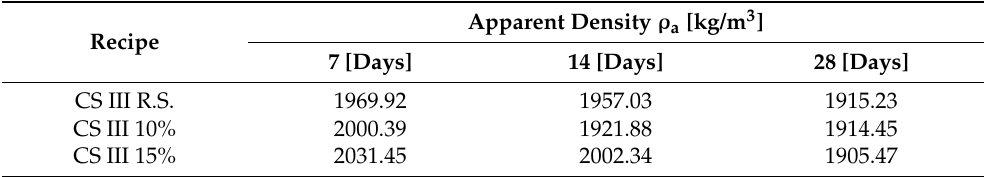
Table 6. Results for apparent density on hardened mortars.